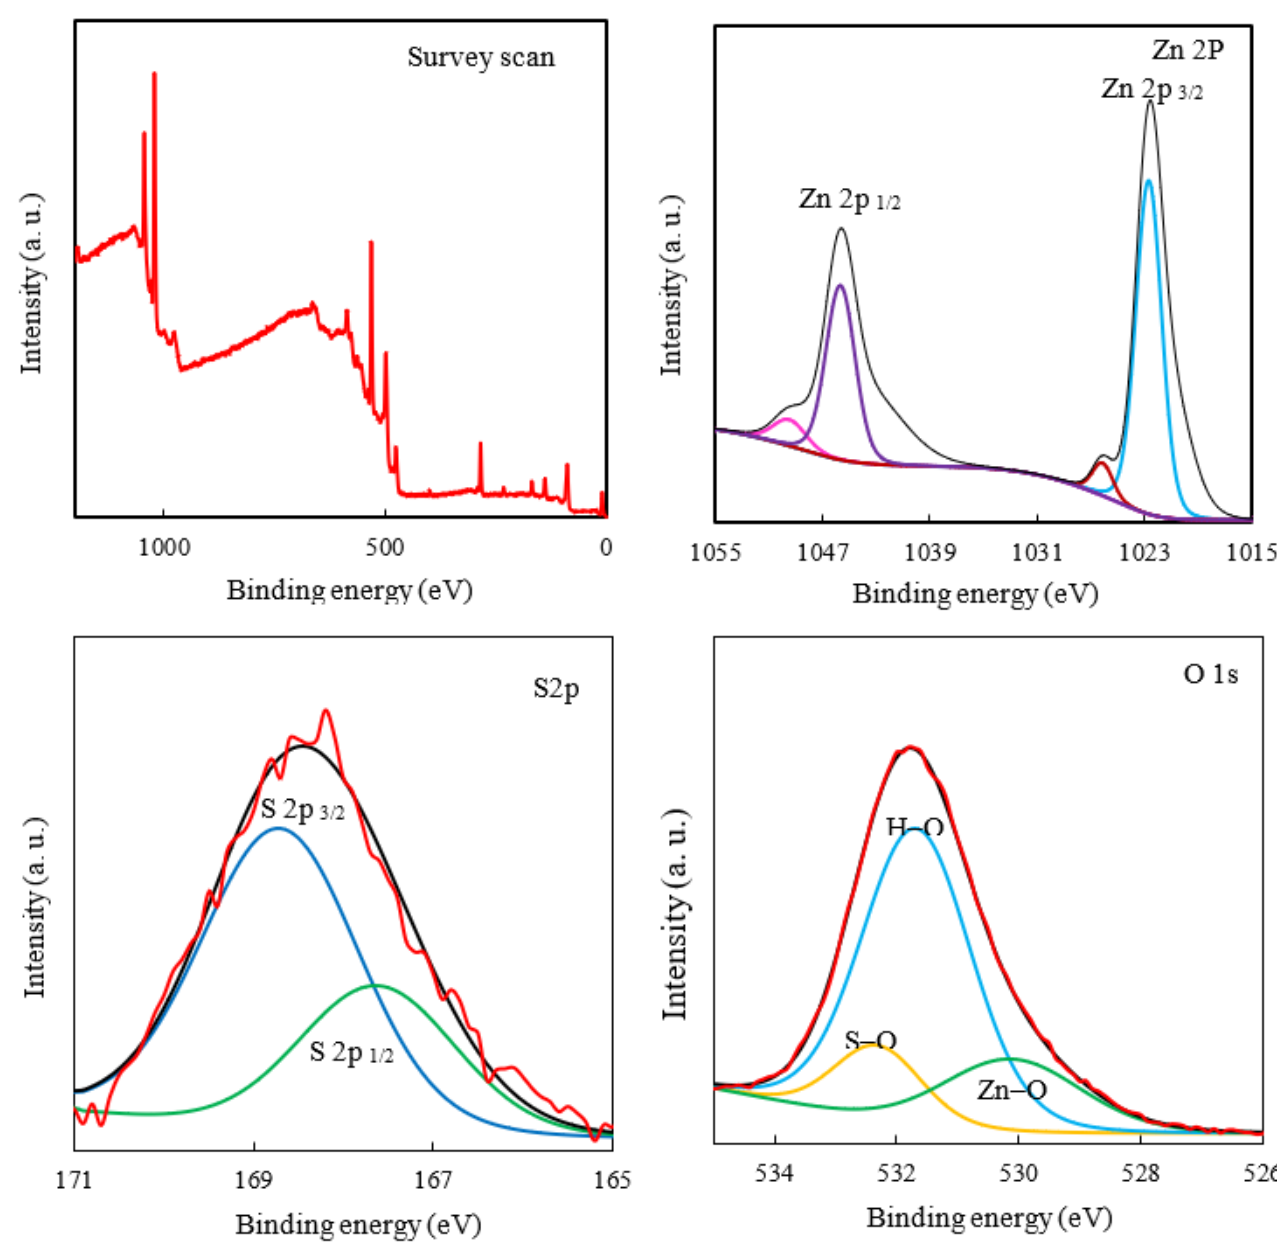
Figure 3. The survey scan and high ‐ resolution XPS spectra of the ZHS nanoplates. Thermal decomposition of the ZHS nanoplates was also studied in the temperature range of 20 to 700 ◦ C [34]. The recorded TGA curve, along with the results of the quan- titative analysis, is given in Figure 4. The thermal decomposition of the ZHS compound includes successive dehydration, dehydroxylation, and SO 2 evolution stages. The dehy- dration process occurs in the low temperature range and does not modify the layered structure [34]. The release of water from the last hydroxide layer causes it to dehydrate. Therefore, ZnO and Zn 3 (OH) 2 (SO 4 ) 2 compounds were formed. Decomposition of the Zn 3 (OH) 2 (SO 4 ) 2 in the second dehydroxylation step leads to the formation of Zn 3 O(SO 4 ) 2 in the intermediate temperature range. Decomposition of the sulfates at high temperatures causes SO 2 gas